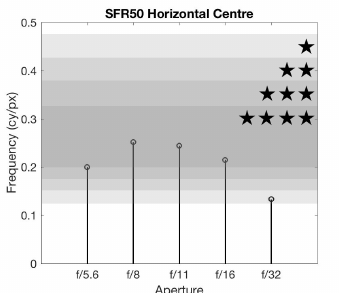
Figure 7. SFR50 for Mango Vase image sets. Grey gradients and stars indicate FADGI star ratings quality